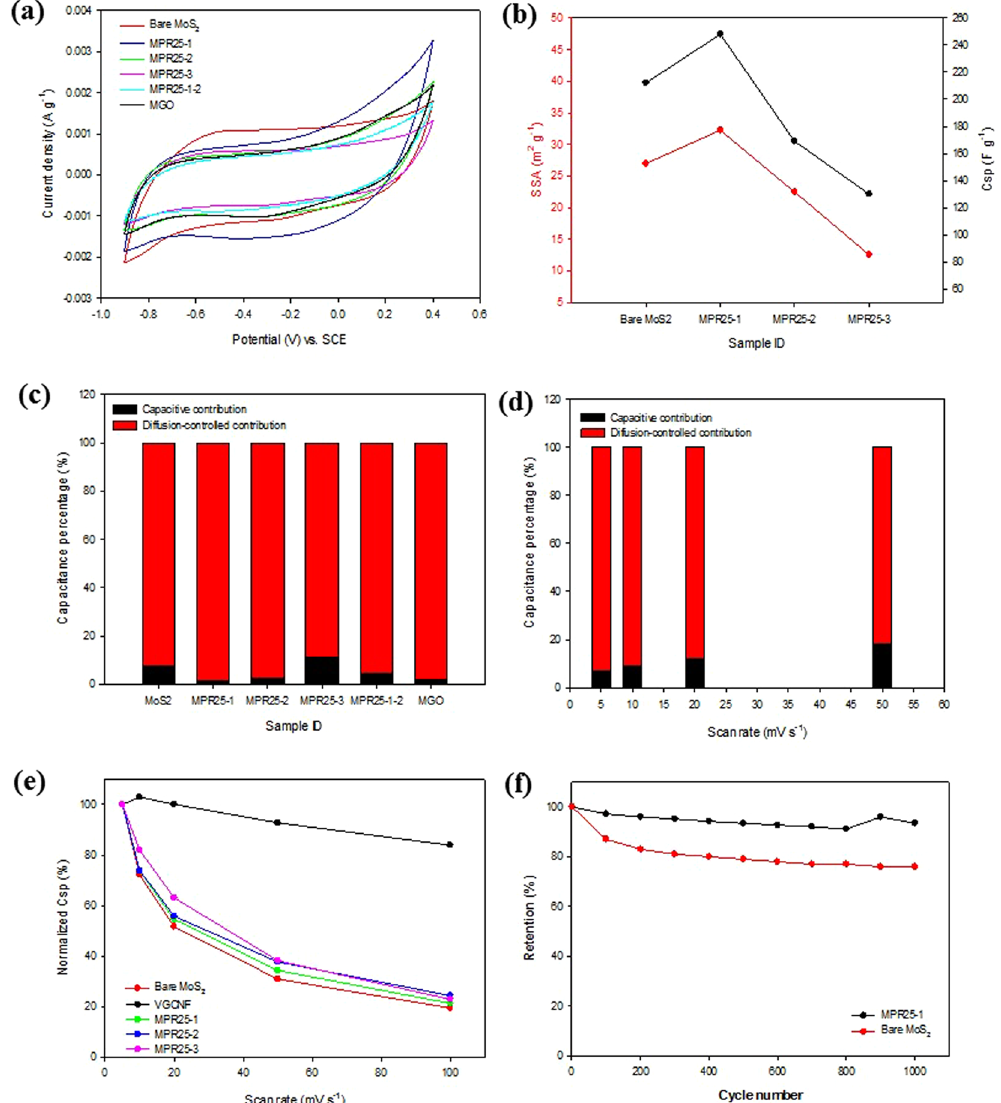
Figure 7. ( a ) CV curves of bare MoS 2 and composites at 5 mV s − 1 and ( b ) the relationship between SSA and Csp of bare MoS 2 and composites. Charge storage calculations of ( c ) bare MoS 2 and composites based on Trasatti’s and ( d ) MPR25-1 based on Dunn’s methods. ( e ) Normalized Csp as a function of scan rate. ( f ) Cyclic stability test of bare MoS 2 and MPR25-1 at 200 mV s − 1